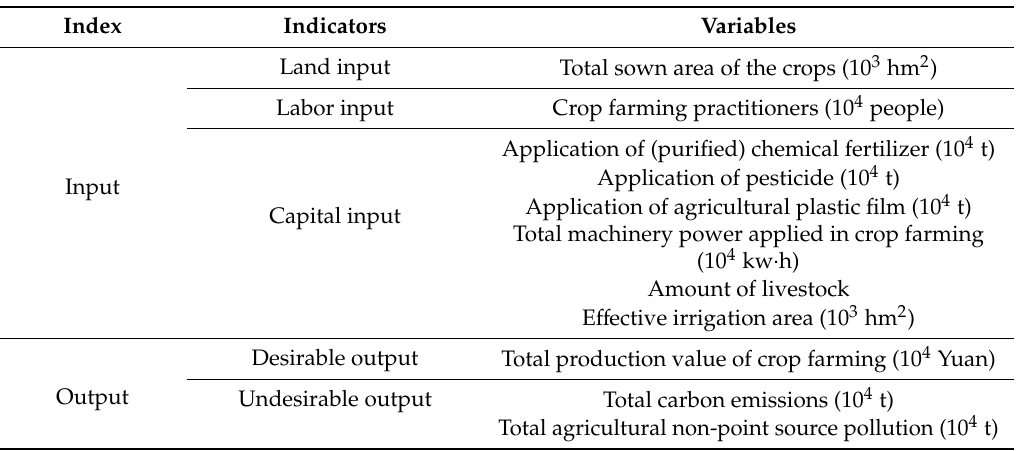
Table 1. Index system of cultivated land use e ffi